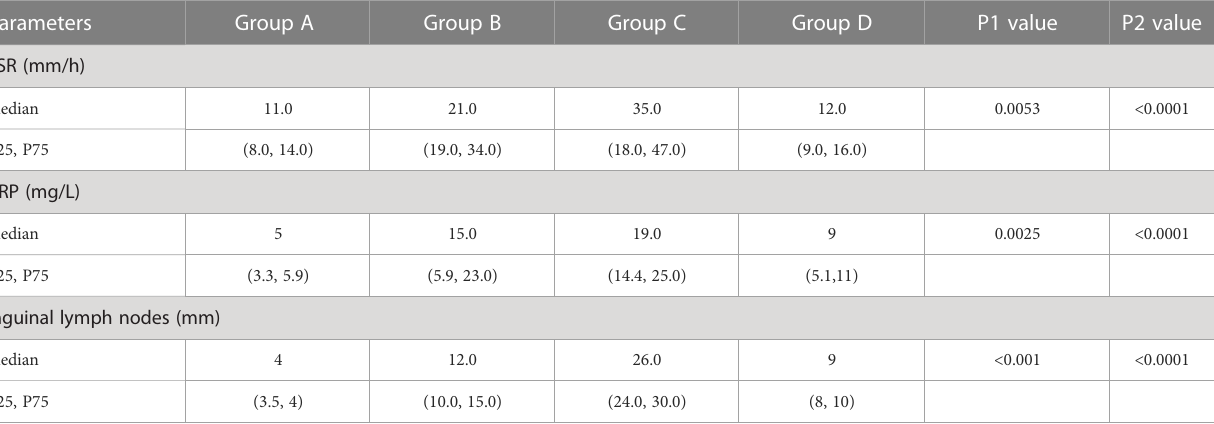
TABLE 2 Comparison of parameters between each group.